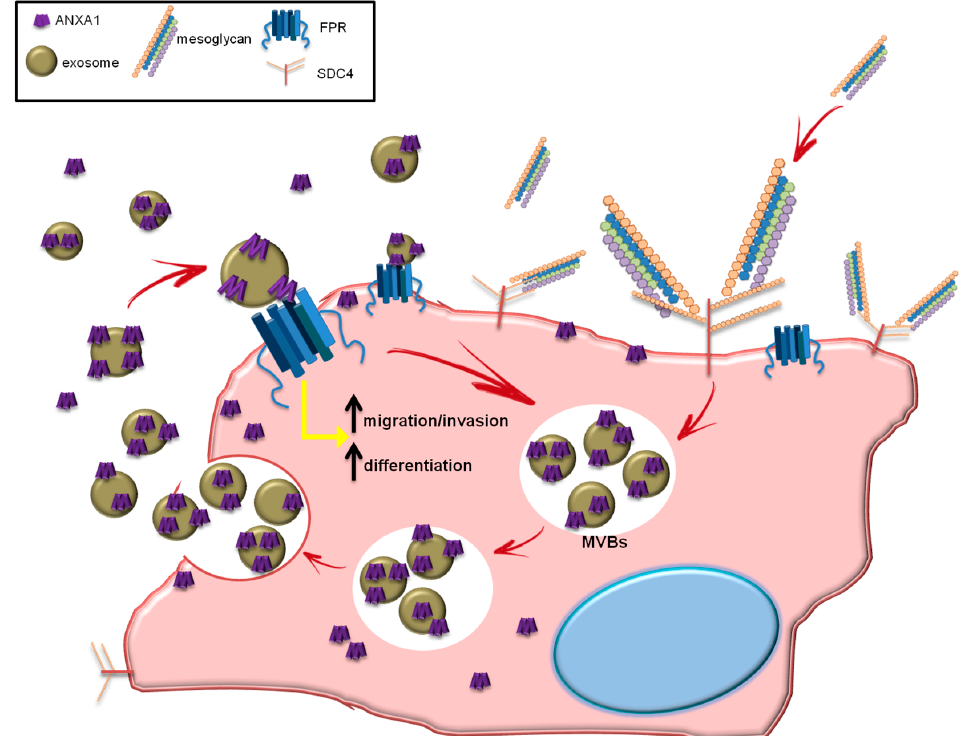
Figure 8. The mesoglycan administered to keratinocytes, interacts with the co-receptors SDC4 through its heparan sulfate components by activating a series of signal transduction events leading to cellular activation. This binding activates SDC4 and promotes the formation of multivesicular bodies (MVBs) which are transported to the plasma membrane for exosome release. The microvesicles released are enriched of all the content of the parent cell, including ANXA1 protein. ANXA1 interacts with FPRs to promote keratinocyte migration and invasion and differentiation. The internal loop triggered by ANXA1 leads to the formation and the release of EVs, amplifying the ANXA1 leads to the formation and the release of EVs, amplifying the biological process. biological process.